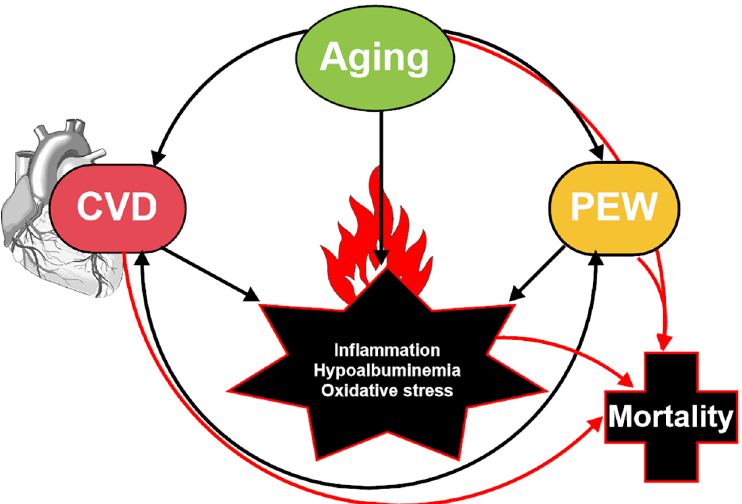
Fig 3. Inflammation/oxidative stress,resulting in hypoalbuminemia, interacts with cardiovascular disease (CVD) and protein-energy wasting (PEW) and together these changes contribute to the increasedmortality in end-stage kidney